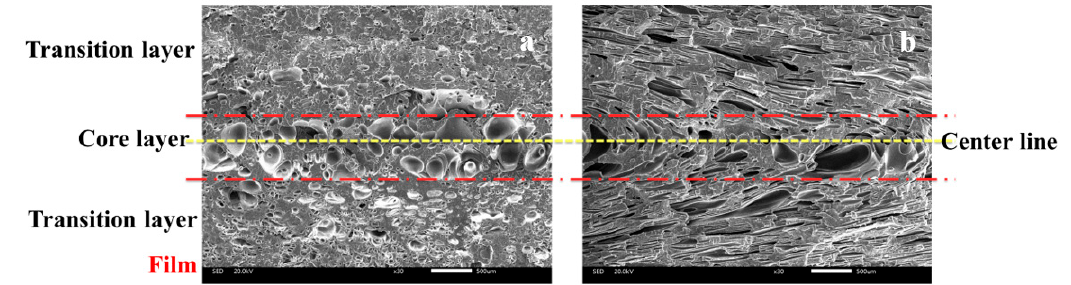
Figure 9. The cellular structure in vertical and parallel sections of IMD / MIM sample: ( a ) vertical section; ( b ) parallel section.